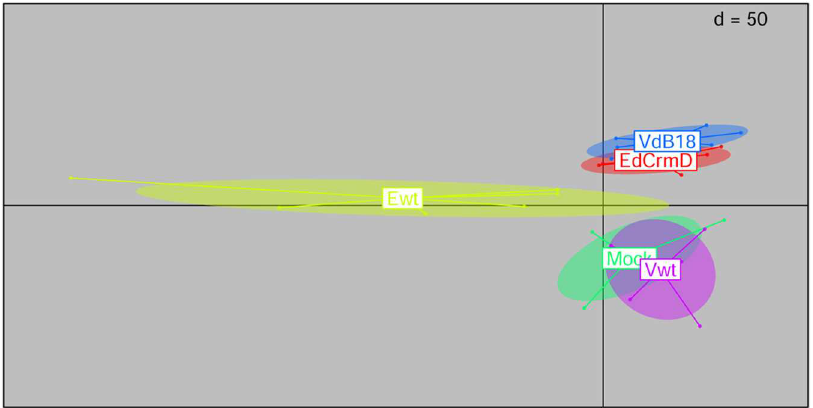
Fig 3. Exploration of trends in host caecaltranscriptomic profiles during early infection. The figure depicts results from an analysiswith respect to instrumental variablesappliedto a principalcomponents analysisbasedon transcriptome profiles (within group analysisusing experimental batch as constraint, followedby a betweenclass analysisusing experimental group as constraint). The analysisordinates samples (n = 6) based on the similarity betweentheir trancriptome profiles. Sample points and experimental group labelsare jointly colored, and ellipsesdescribethe experimental groups’